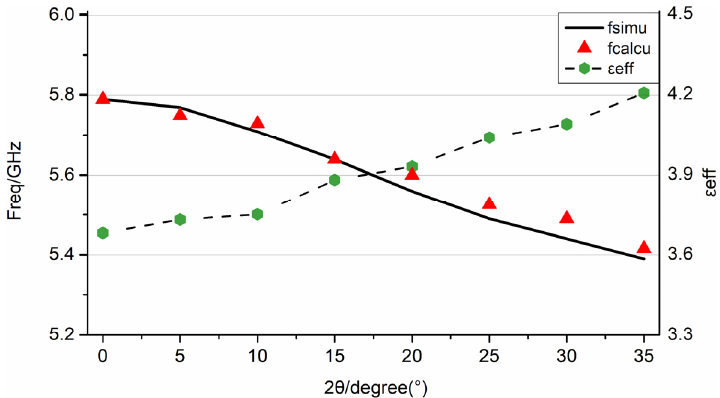
Figure 5. Comparison of full-wave simulation frequencies and the theoretically predicted frequencies with different bending angles, represented by the solid black line and red marks, respectively.